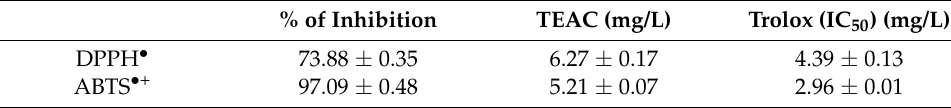
Table 3. In vitro antioxidant activity of FEO.